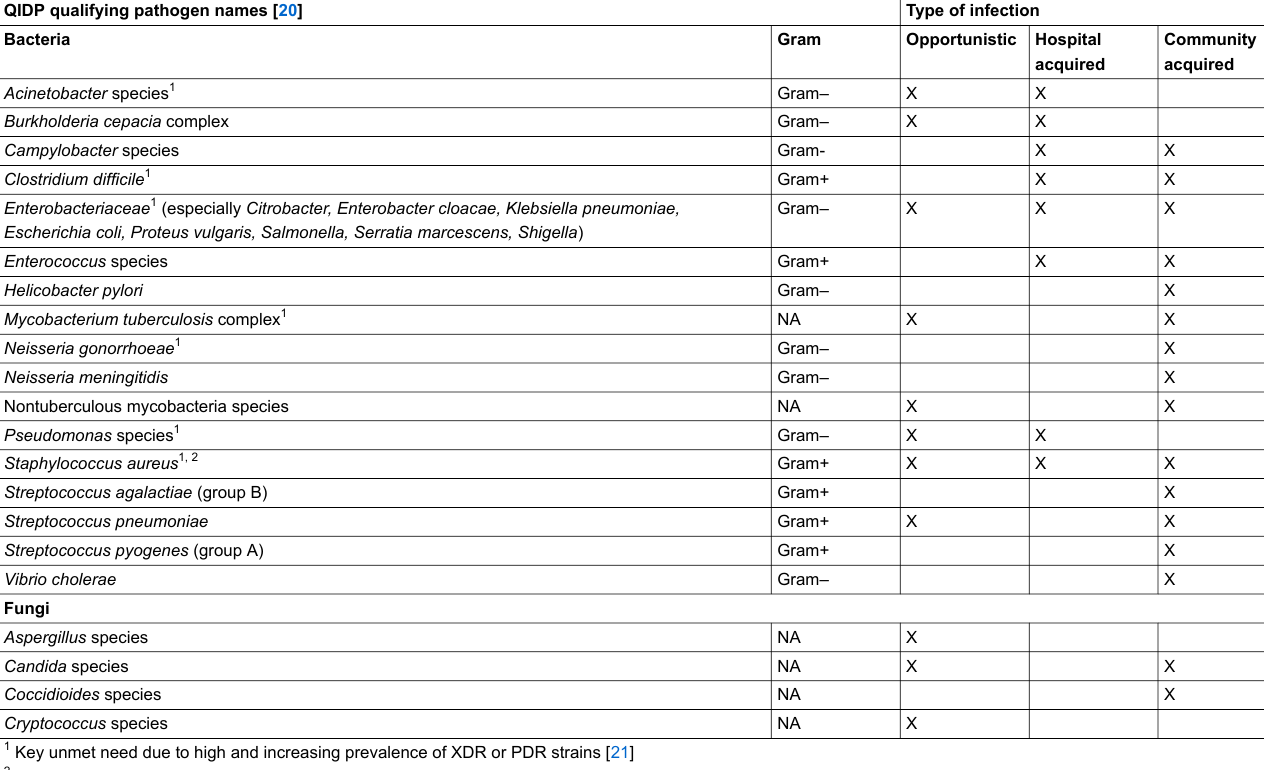
Table 1: Qualified infectious disease product (QIDP) qualifying pathogens: pathogens that have the highest unmet medical need. QIDP qualifying pathogen names